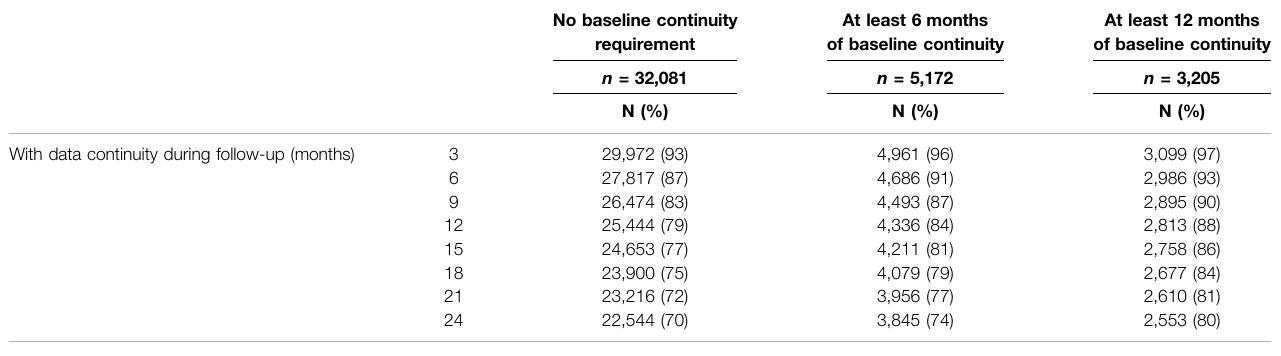
TABLE1| Datacontinuityduringfollow-up,bybaselinecontinuityrequirement,amongoralhypoglycemicagentuserswhowereeligibletobefollowedforatleast24 months in the Integrated Medical Database of National Taiwan University Hospital ( n = 32,081).